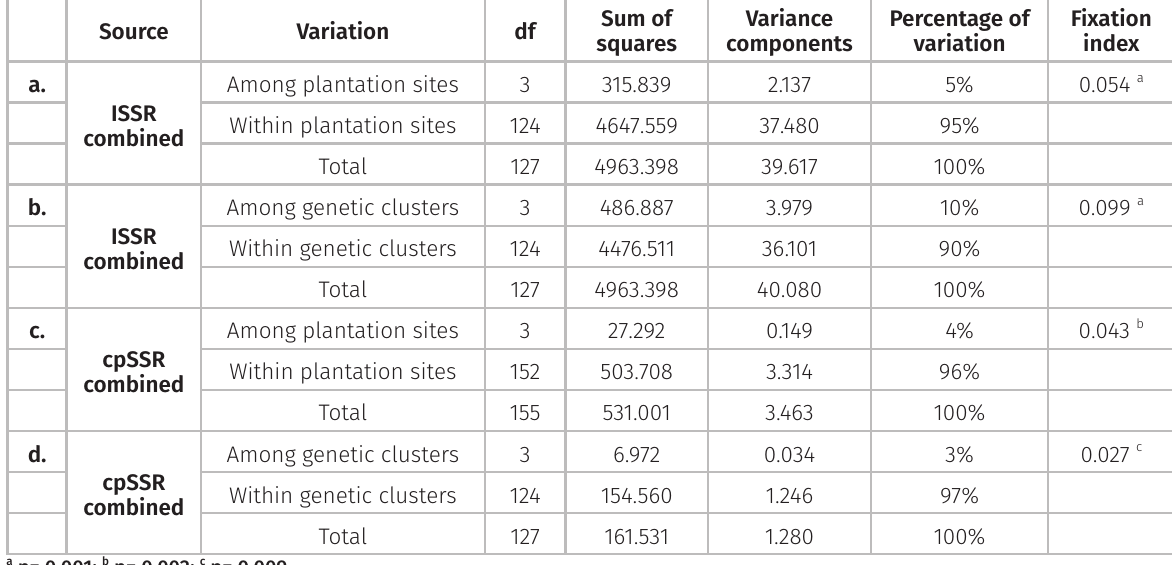
Percentage of variation